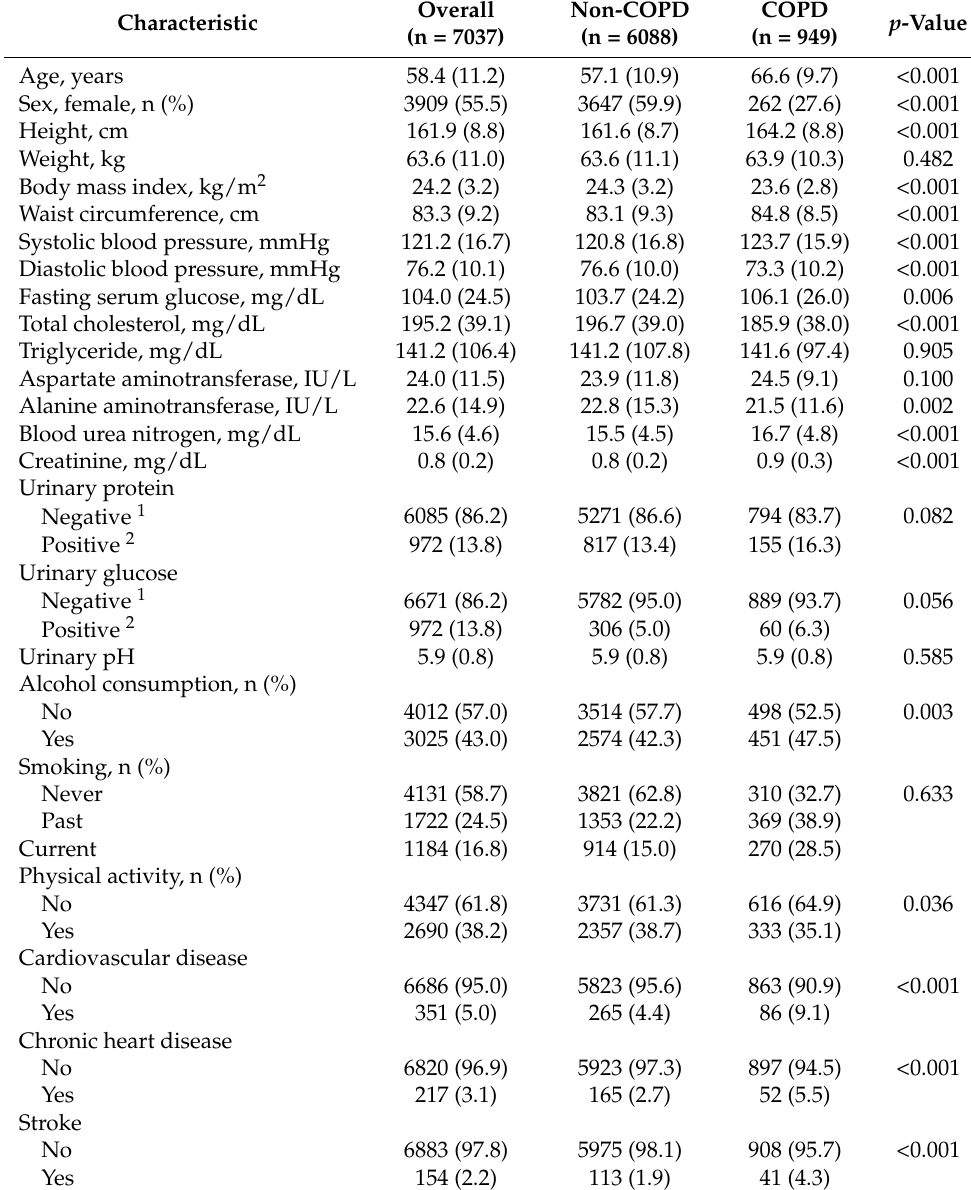
Table 1. Descriptive characteristics of the participants in the training